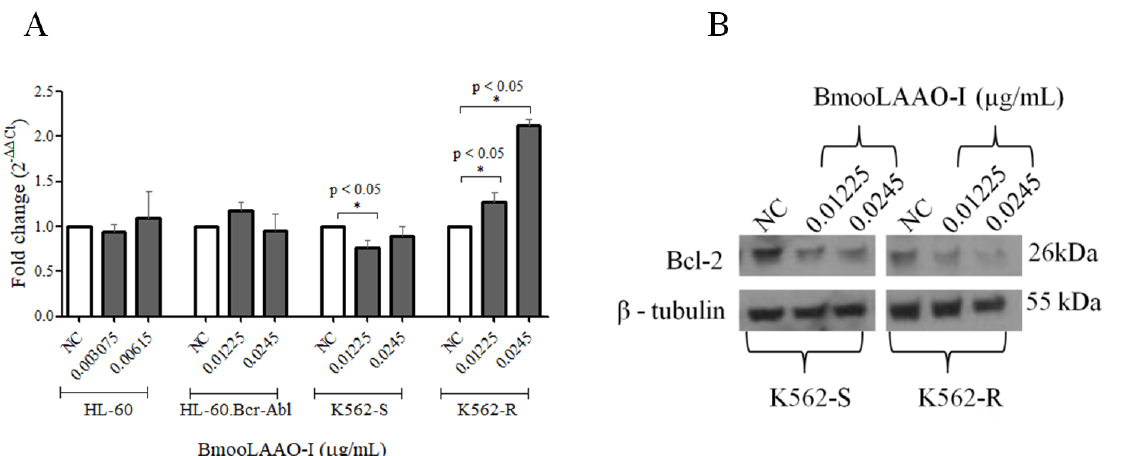
Figure 6. Quantification of miR-16 and Bcl-2 expression in tumor cell lines treated with BmooLAAO-I. The expression levels of (A) the apoptomiR miR-16 and (B) Bcl-2 were quantified by real-time PCR in HL-60, HL-60.Bcr-Abl, K562-S, and K562-R cells treated for 24 h with BmooLAAO-I at sublethal concentrations. Results were expressed as mean fold change ± standard deviation of three independent experiments. NC: negative control (untreated cells). * p < 0.05 vs. NC (one-way ANOVA followed by the Tukey’s post-hoc